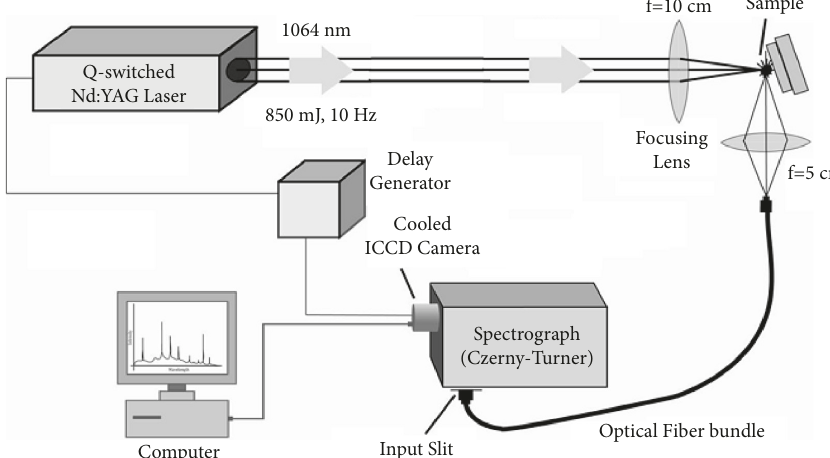
Figure 1: Schematic diagram of the LIBS experimental setup (adapted from